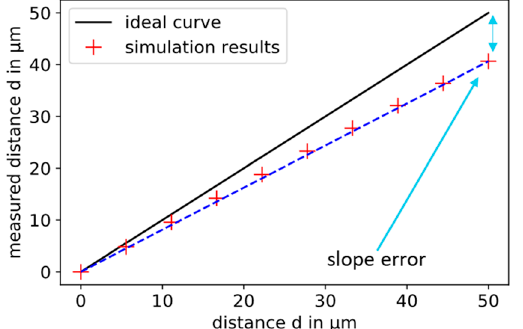
Figure 3. Result of the simulated capacitive displacement measurement with a simple parallel plate capacitor. The black line corresponds to the ideal curve. The red crosses are the simulation results. The capacitance is calculated for 10 plate distances and converted into a “measured” displacement using the ideal Equation (1). The minimum and the maximum are connected by a straight line (dashed blue). The difference between the end of the ideal line and the last calculated displacement is the slope error.